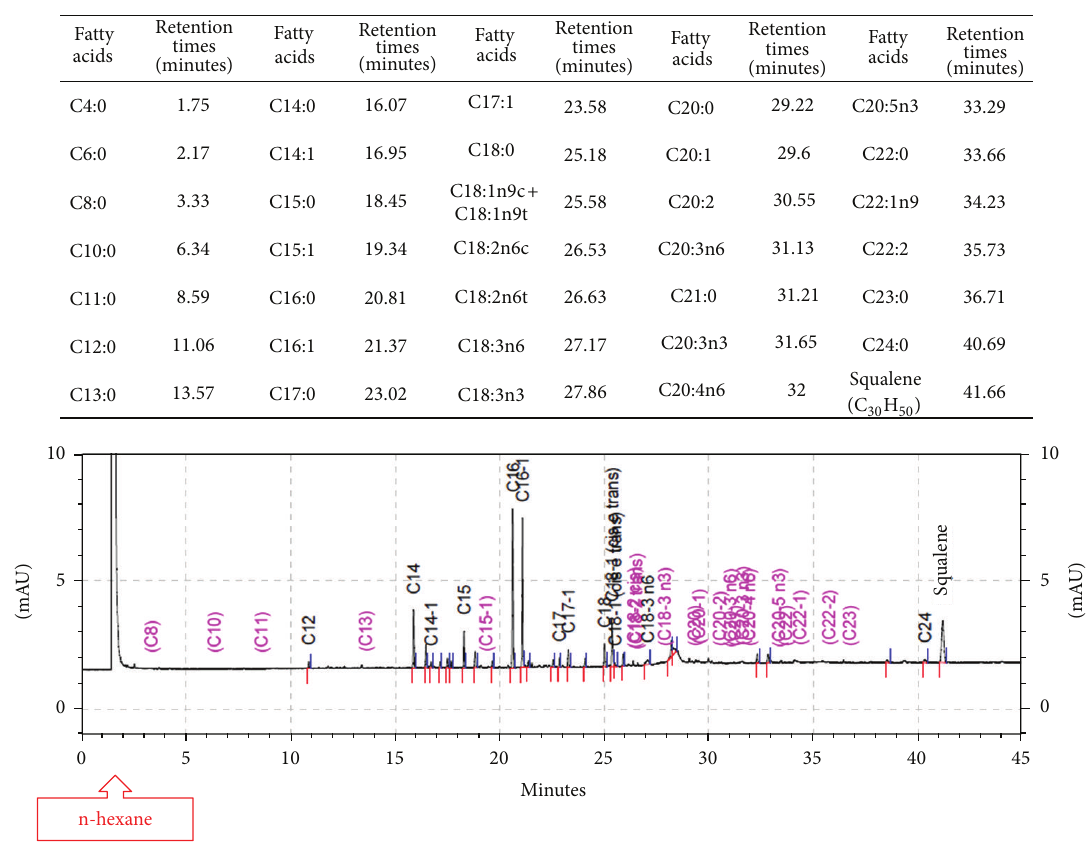
Figure 1: Evaluated fatty acids, their respective retention times, and example of chromatographic result